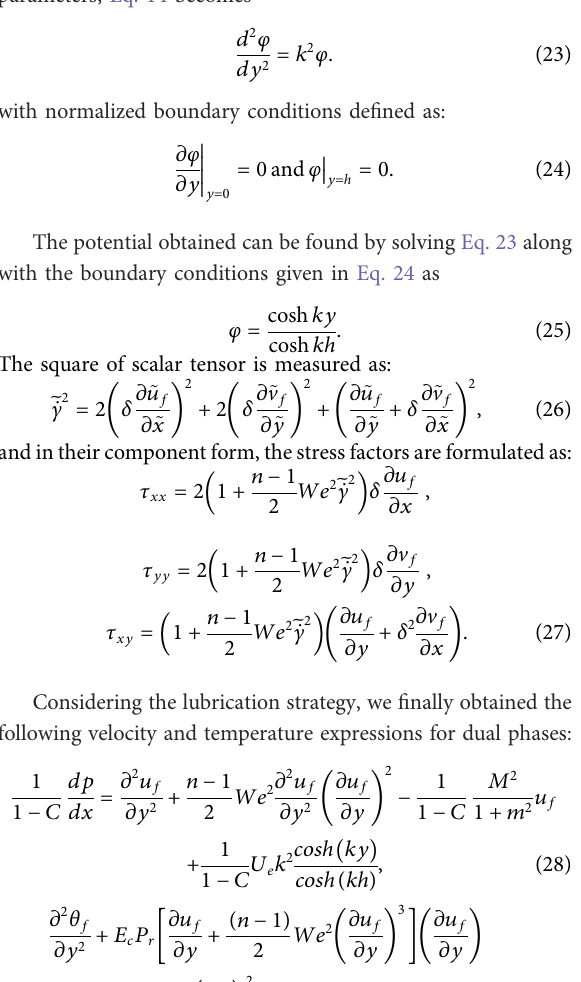
FIGURE 2 Temperature pro fi le for various values of E 1